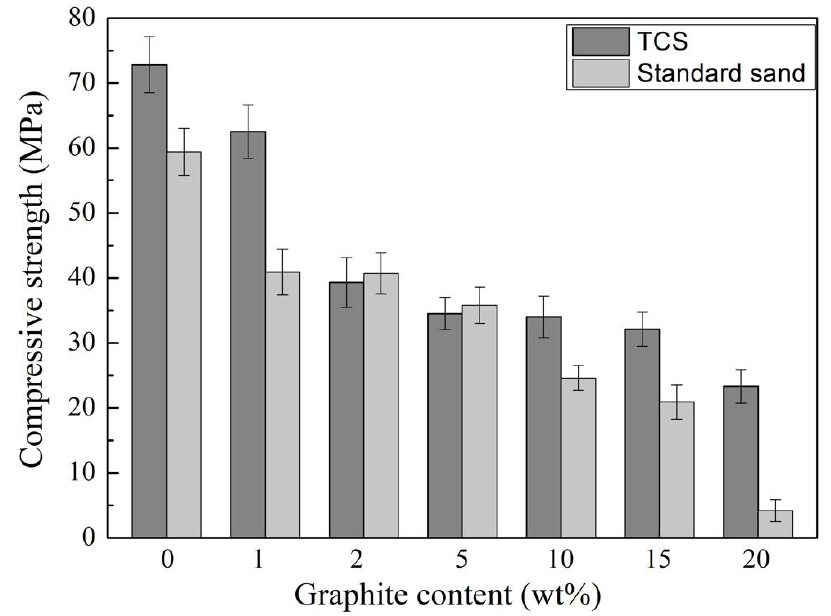
Figure 8. Effect of graphite content on the compressive strength of cement mortars cured for 28 days with different aggregates.